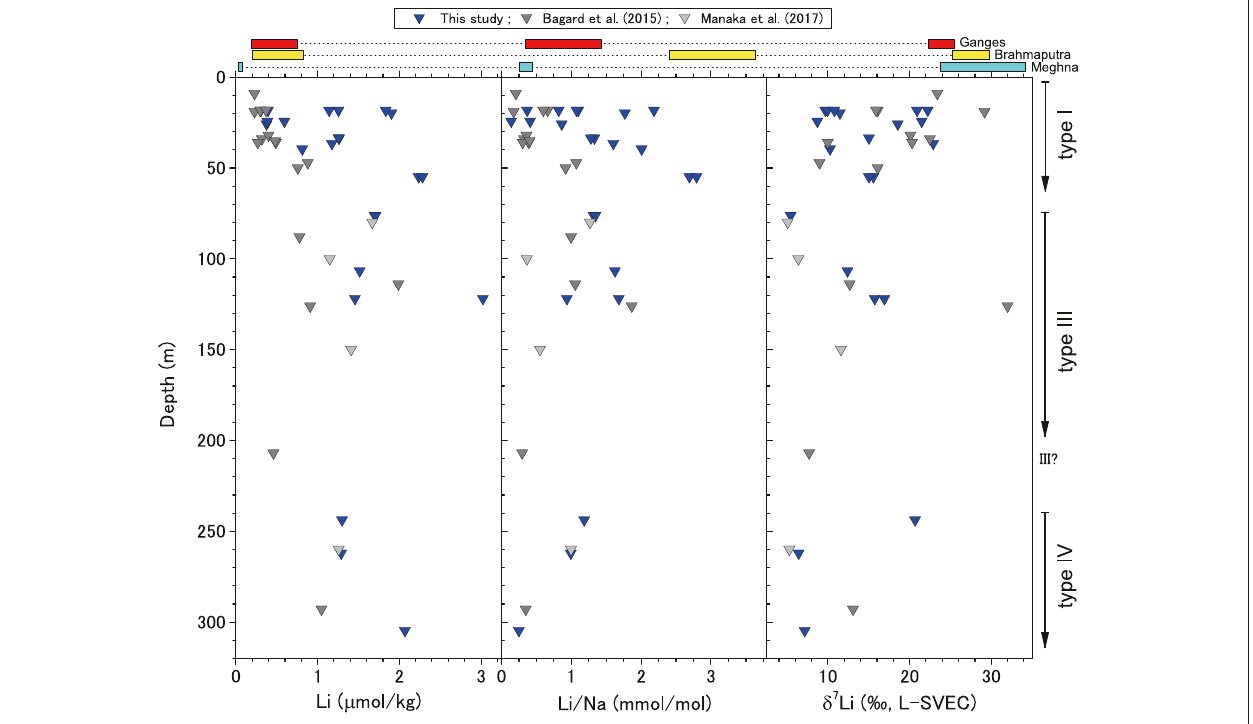
Frontiers in Earth Science |